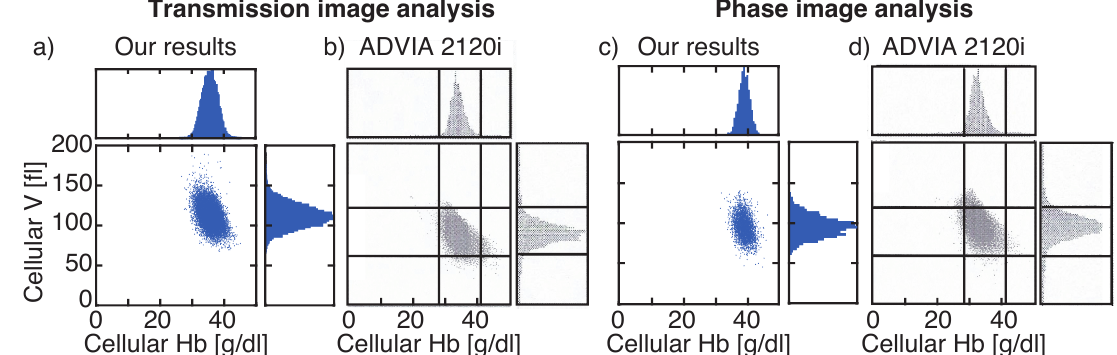
Figure 6. Comparison of red blood cell (RBC) cytograms showing cellular volume and cellular hemoglobin obtained by our systems for transmission ( a ) or phase images ( c ) and obtained by the reference system Siemens ADVIA 2120i ( b , d ). Different blood samples were investigated for transmission and phase images. Histograms highlight the distribution widths. Vertical lines in ( b , d ) are located at 28g/dL and 41g/dL and horizontal lines at 60fl and 120fl. Vertical axes are all the same for all